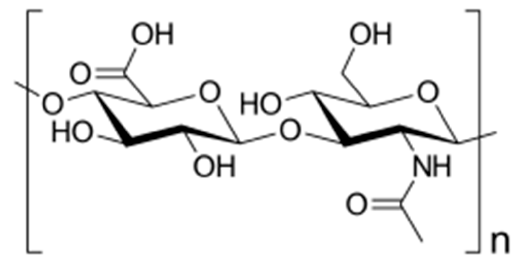
Figure 8. Chemical structure of hyaluronic acid (HA).